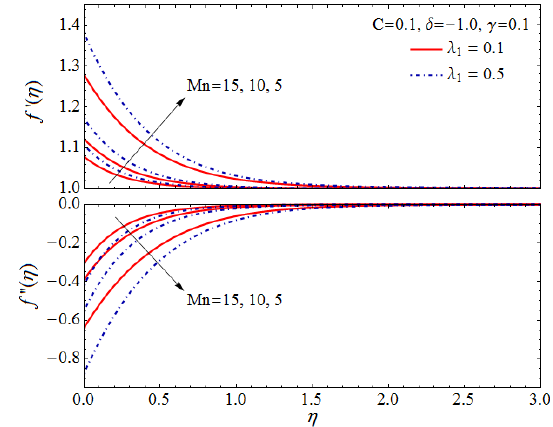
Fig. 4 Dimensionless velocity profile f (cid:48) ( η ) and shear stress profile f (cid:48)(cid:48) ( η ) for various values of Mn and γ .